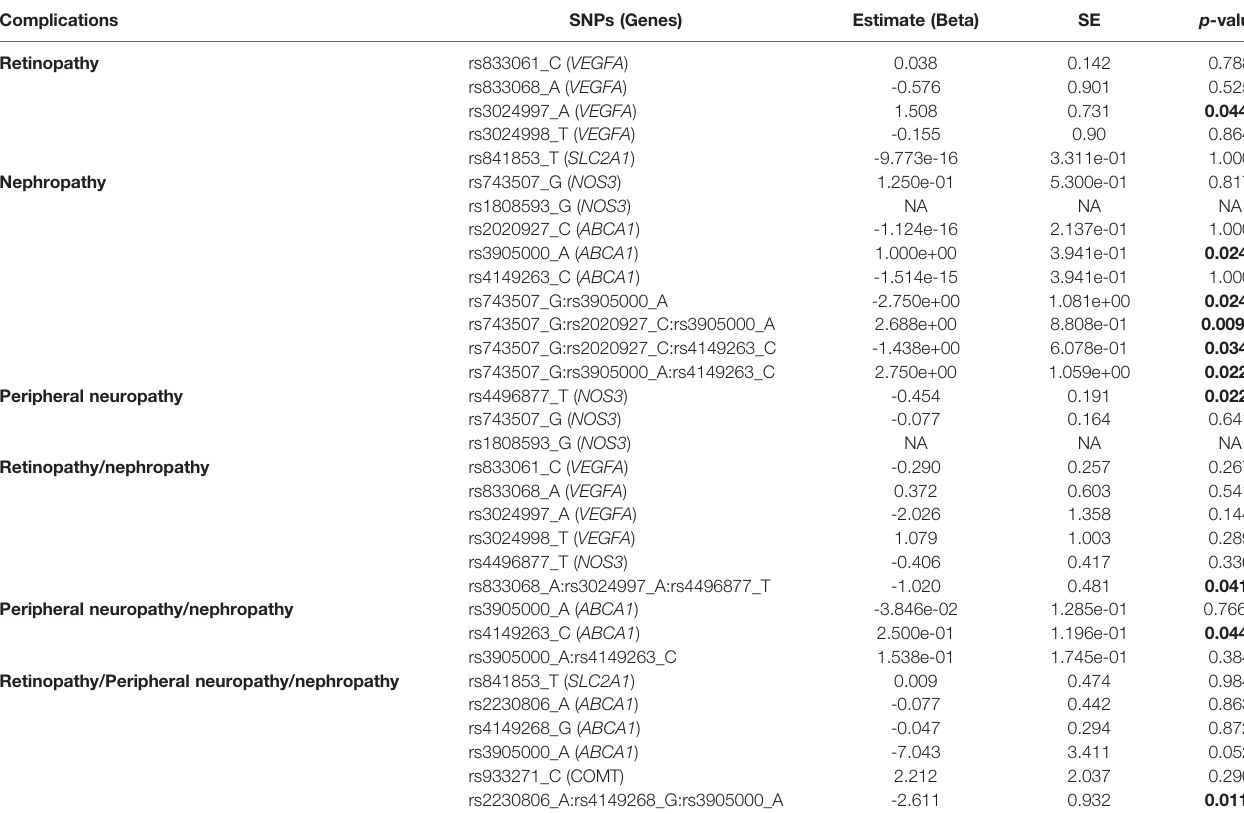
Values in bold indicate signi fi cant *p-value for < 0.05. SNP, single nucleotide polymorphism; Beta, regression coef fi cient for interaction in logistic regression; SE, standard error; SLC2A1, SoluteCarrierFamily2Member1;VEGFA,VascularendothelialgrowthfactorA;NOS3,NitricOxideSynthase 3;ABCA1,ATPBindingCassetteSubfamilyAMember1;COMT,Catechol-